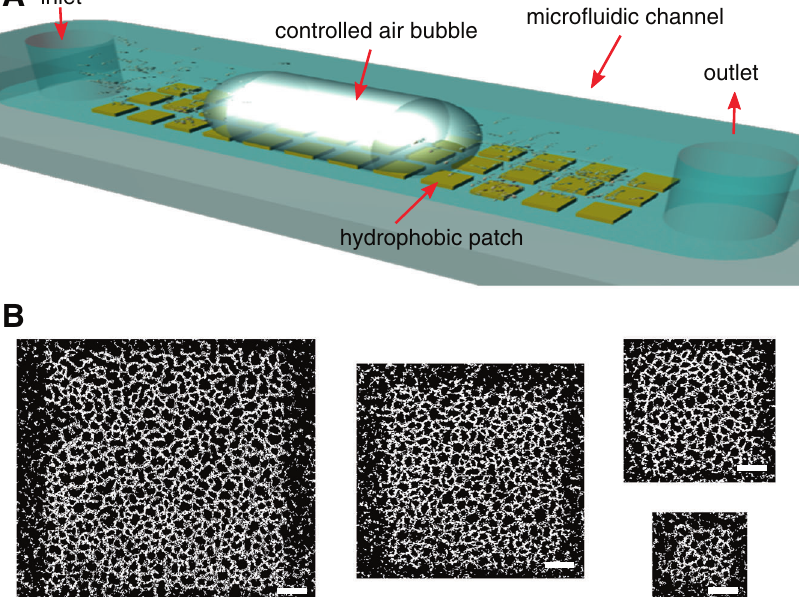
Fig. 1 The passage of a long air bubble creates a characteristic pattern of holes in a bio fi lm. a Schematic of the micro fl uidic setup showing the geometry of the microchannel and the experimental method, in which P. aeruginosa bacteria preferentially attached to hydrophobic patches. After a speci fi ed growth time (4 h, 8 h, or 12 h), a controlled air bubble was injected in the channel at a mean fl ow speed of 250 µm s − 1 . b Residual bio fi lm after the passage of the bubble, revealing a semi-regular pattern of holes formed in an 8 h-old bio fi lm, for different initial patch sizes (measuring 400 2 μ m 2 , 300 2 μ m 2 , 200 2 μ m 2 , and 100 2 μ m 2 ). Scale bars, 50